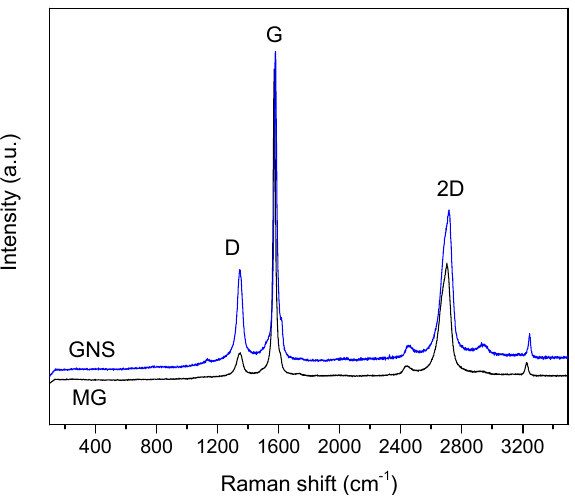
Figure 3. Raman spectra of MG and GNS samples.